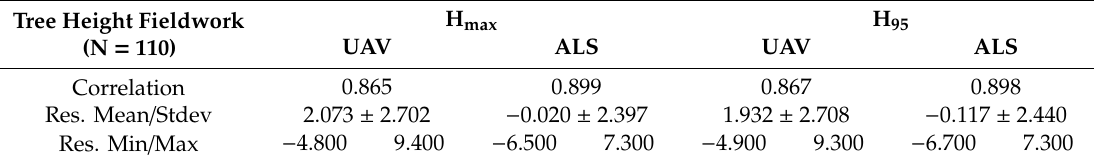
Table 7. Tree height correlation coe ffi cients between UAV and fieldwork and ALS and fieldwork. Tree Height Fieldwork